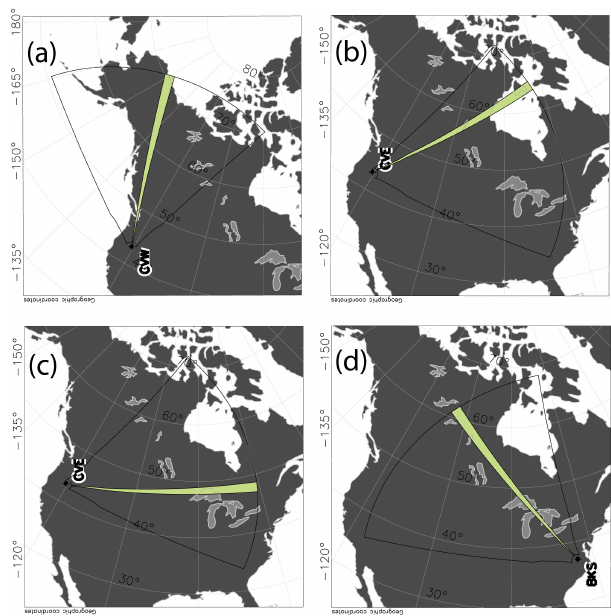
Figure 10. Radar FoVs and selected beams of (a) the Christmas Valley West (CVW) radar beam 12, (b) the Christmas Valley East (CVE) radar beam 5 (c) the CVE radar beam 15, and (d) the Black- stone (BKS) radar beam 15 used in Fig.